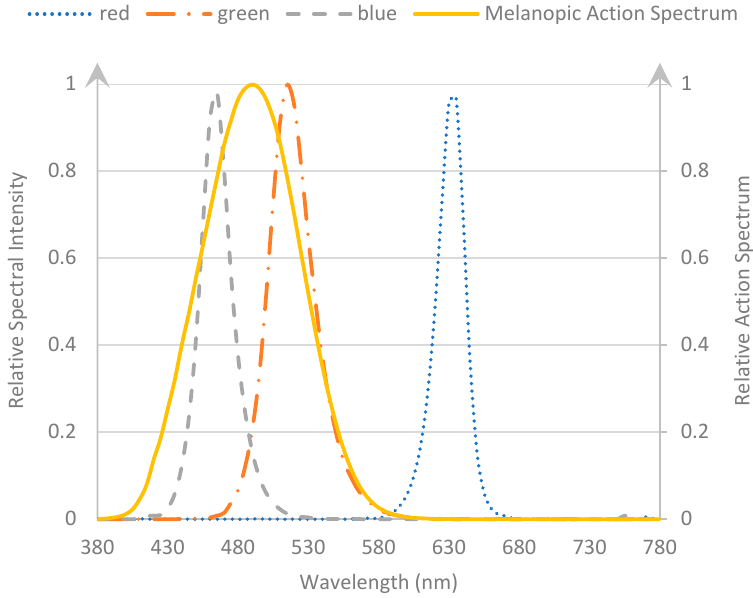
Figure 2. Relative spectral intensity of R/G/B chips used in the LED screen.